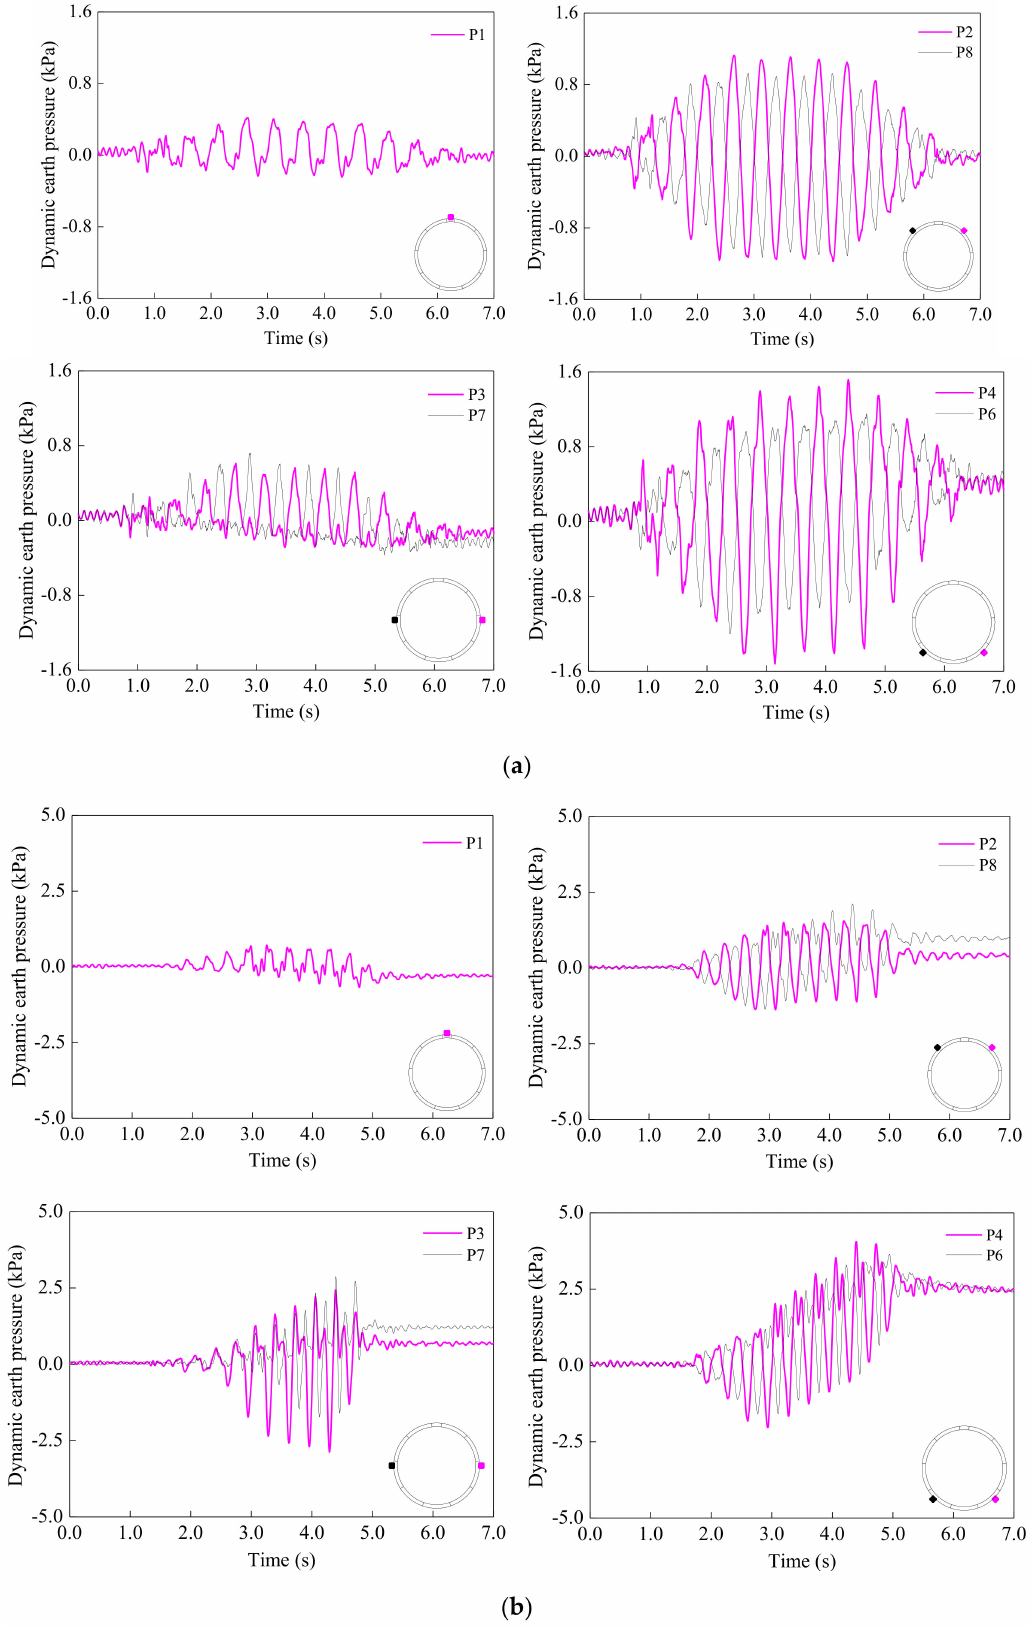
Figure 22. The dynamic soil pressure of segmental tunnel. ( a ) Sin-2. ( b )